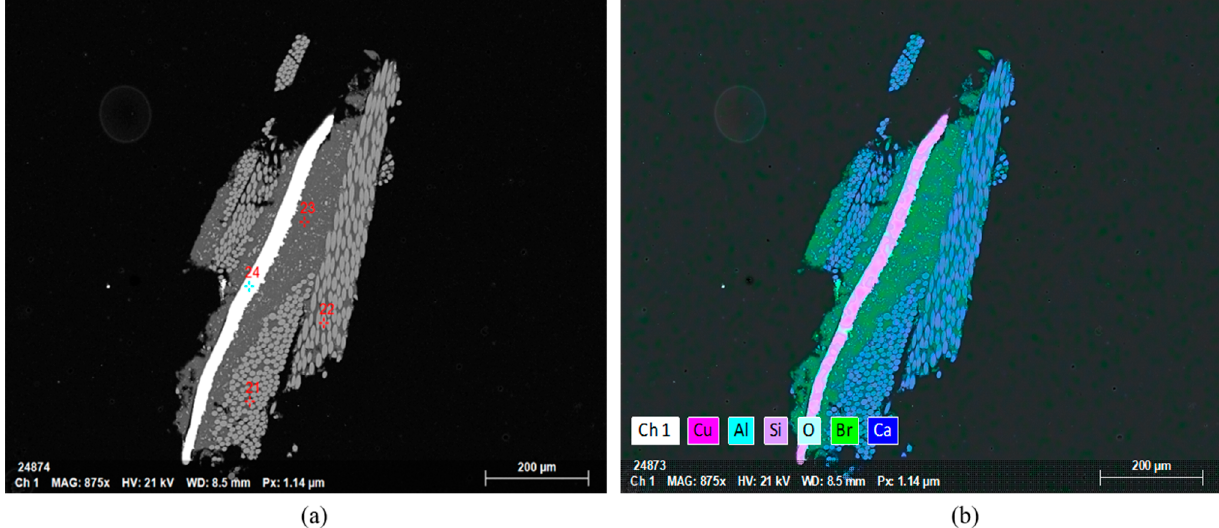
Figure 12. Micrographs (BSE-SEM) of a feed PCB, ( a ) BSE-SEM image; ( b ) EDS-SEM image.